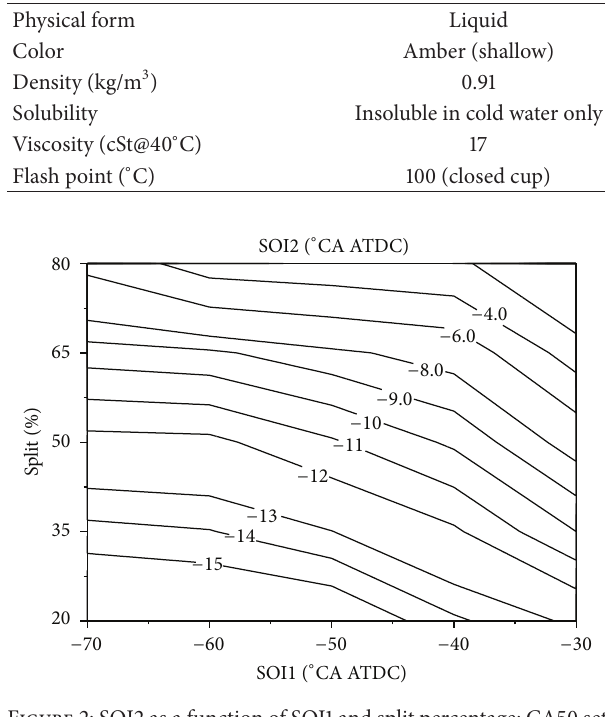
Figure 2: SOI2 as a function of SOI1 and split percentage; CA50 set at 10 ∘ CA ATDC.